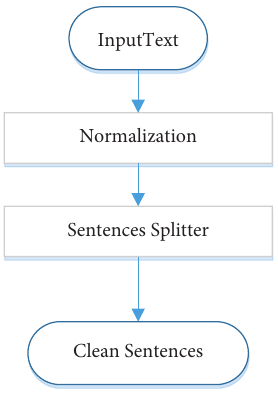
Figure 4: The preprocessing